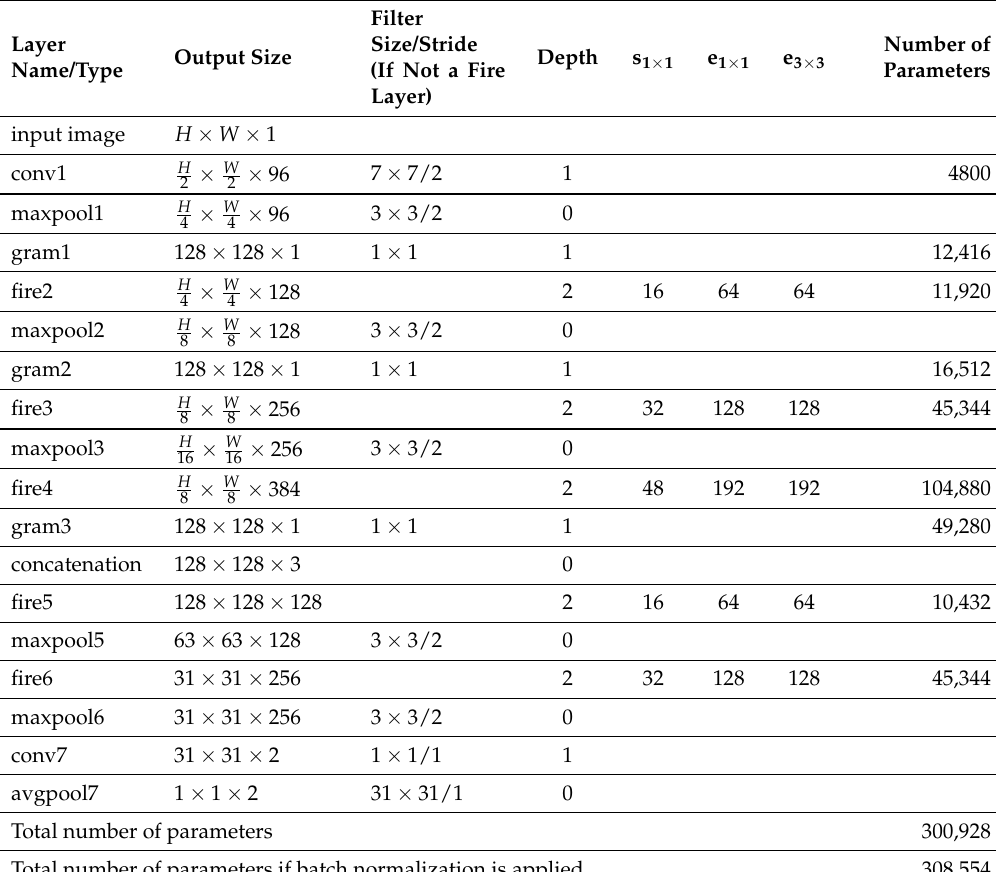
Figure 5. The architecture of fingerprint Presentation Attack Detection network (fPADnet). Table 1. Structure of the proposed